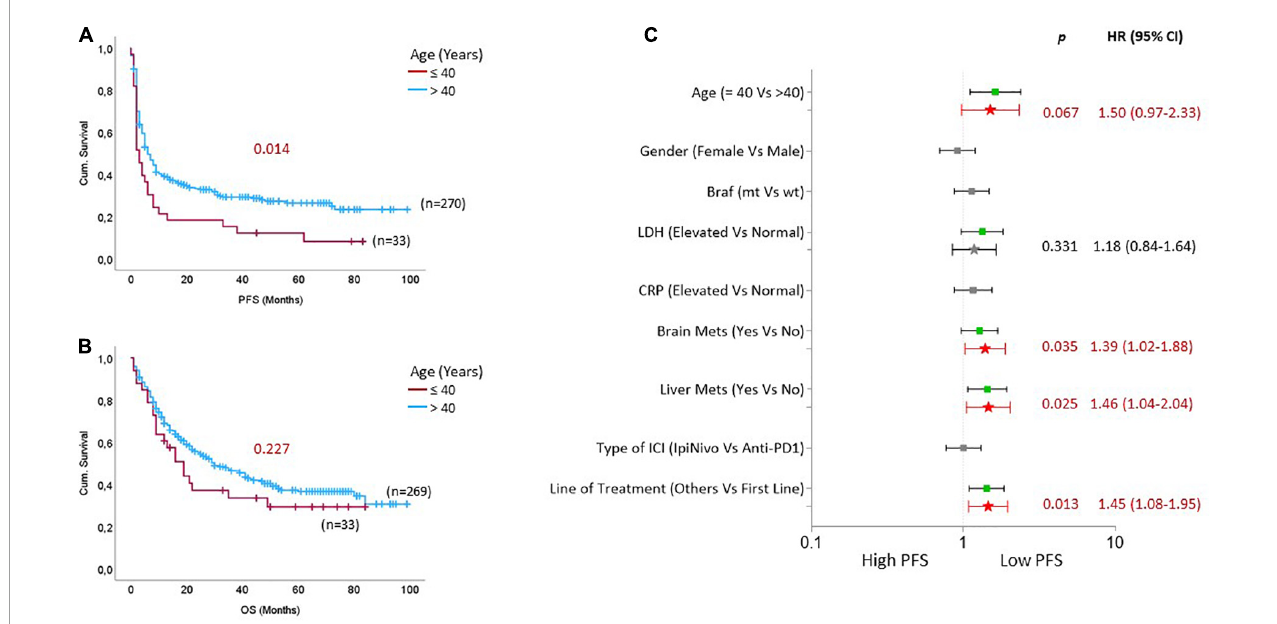
FIGURE1 Rapid disease progression on immune checkpoint inhibitors (ICIs) in young patients with stage IV cutaneous melanoma. Kaplan Meier curves based on age groups for (A) progression-free survival and (B) overall survival. (C) The forest plot indicates univariate (box symbol) and multivariate regression (star symbol) analysis for PFS of ICI-treated mCM patients. The green color in the plot indicates that this clinical feature is a high-risk factor for PFS in univariate analysis, and the bright red indicates a high-risk factor in the multivariate model. P -values from the multivariate analysis are presented on the